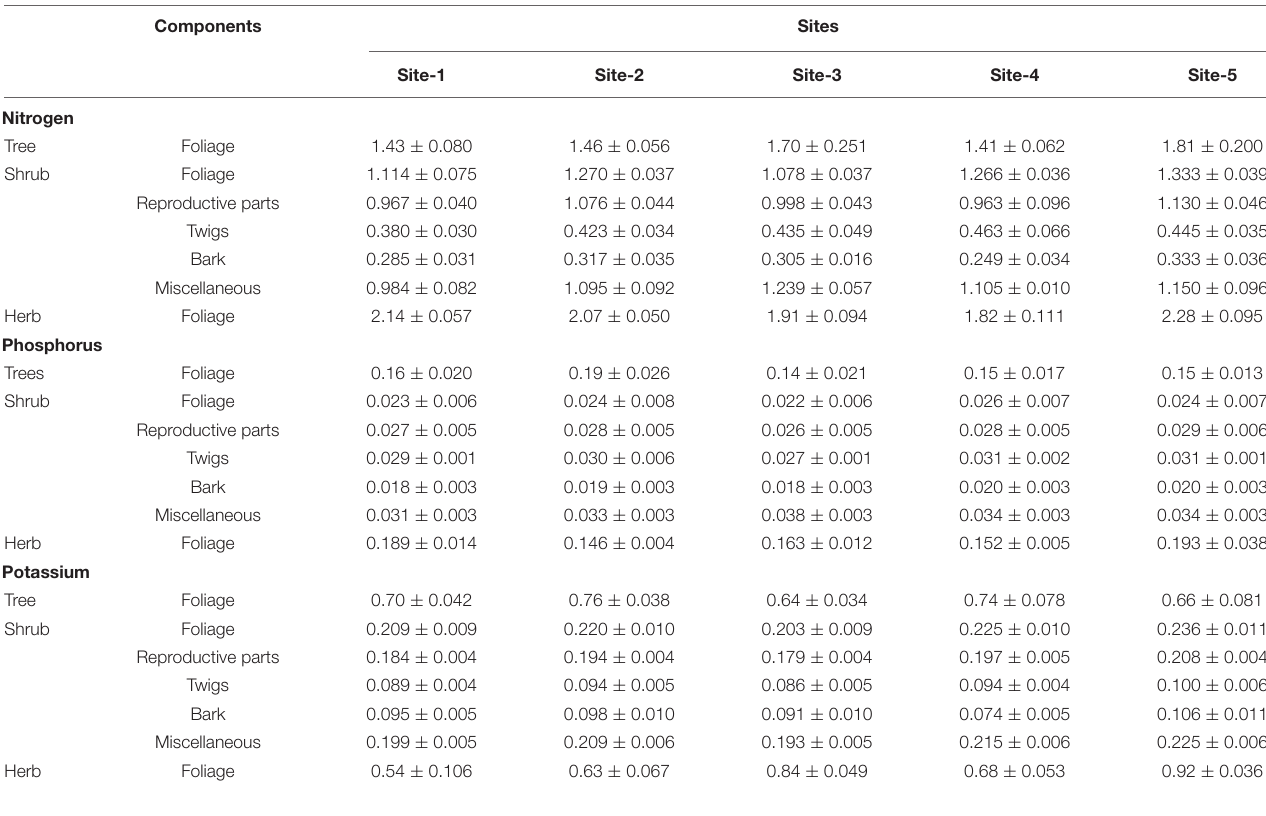
TABLE 6 | Average concentration of nutrients (%) in different components in litter across seasons for the selected